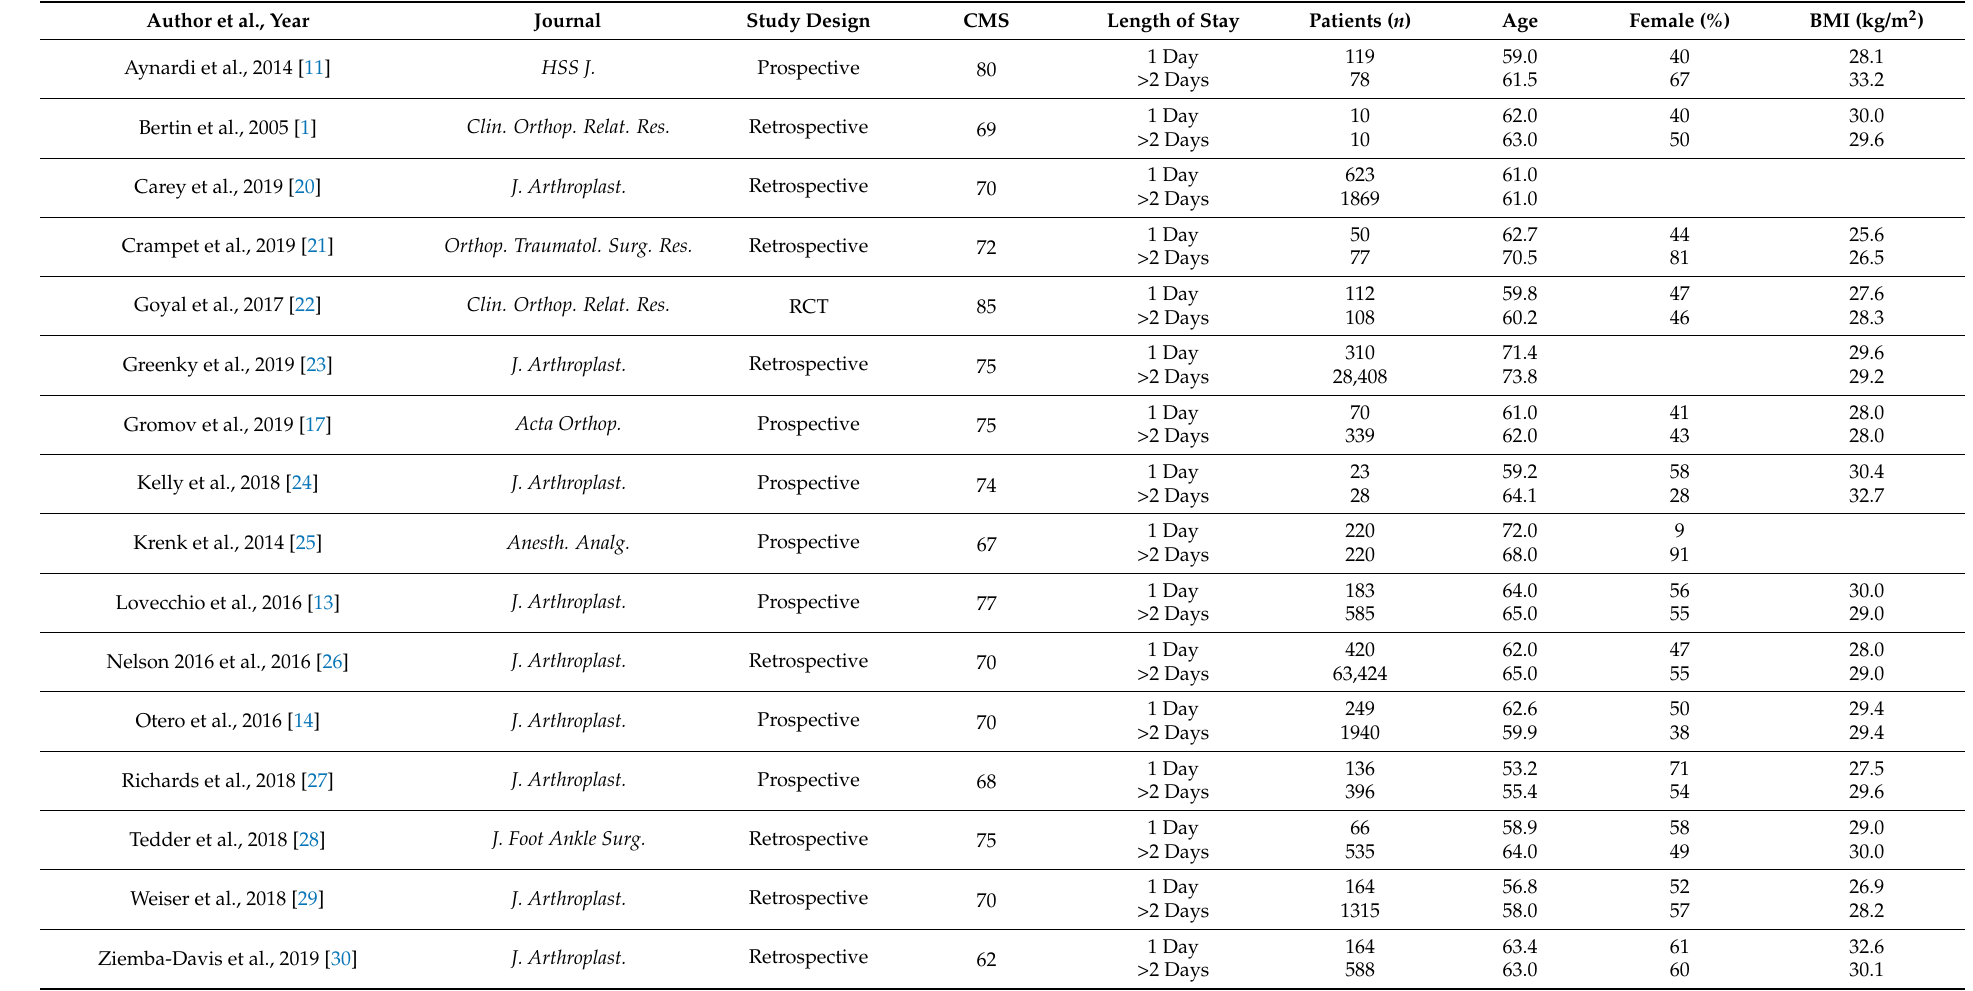
Table 2. Studies generalities and patient demographics (CMS: Coleman Methodology